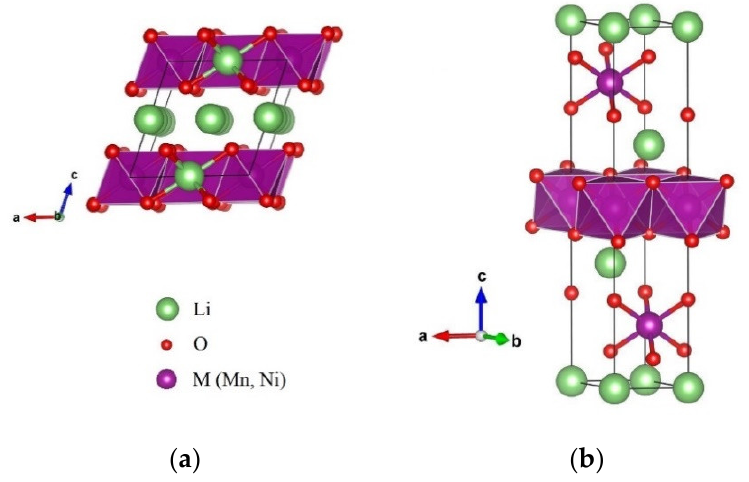
Figure 2. Crystal structure of ( a ) monoclinic Li 2 MnO 3 structure with space group C2/m and ( b ) rhombohedral LiMO 2 structure. M = Ni, Mn with space group R3m using VESTA software.